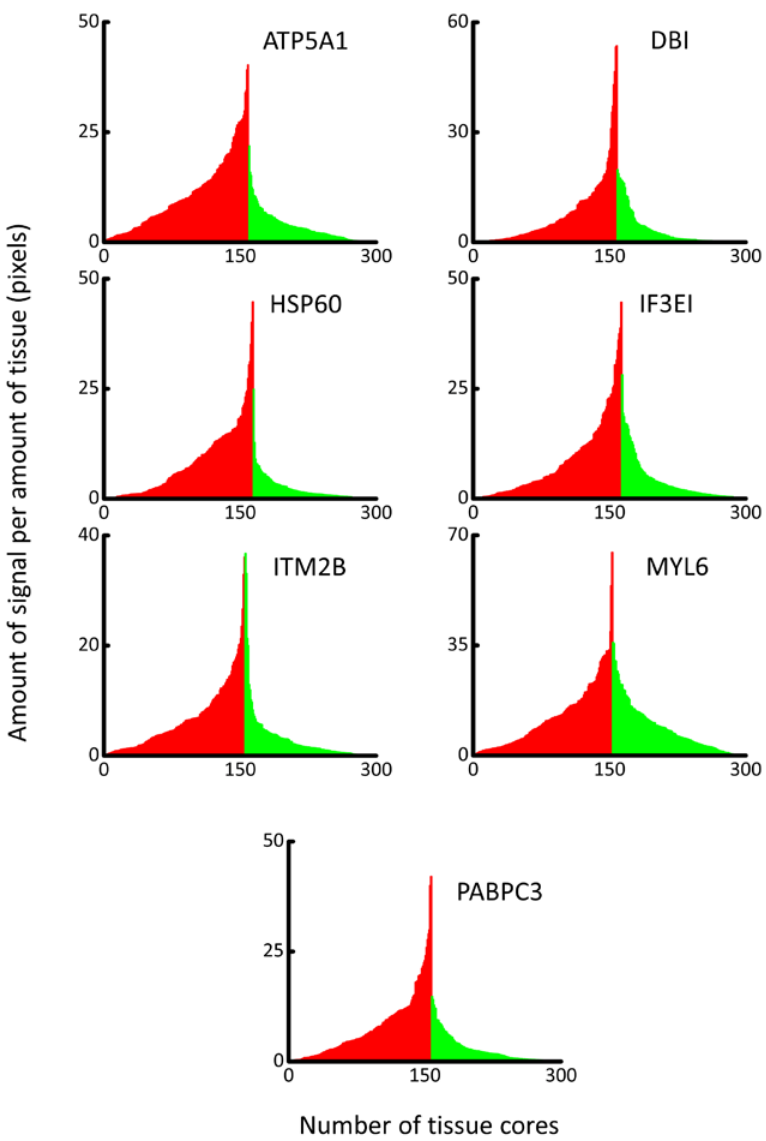
Figure 2. Mountain Plots . The total area of DAB stain and the total quantity of tissue present in each tissue core (pixels) was measured using a high throughput, semi-automated protocol using ImageJ software. Mountain plots illustrating the amount of DAB signal per amount of tissue in each tissue core. Red bars represent HR cores arranged in ascending order and green bars are LR tissue cores arranged in descending order. Plots were constructed in Origin (OriginLab, Northampton, MA, USA) software. Significant differences between protein expression in HR and LR tissue cores were observed in all proteins tested: ATP5A1 ( p < 0.001), DBI ( p < 0.001), HSP60 ( p < 0.001), IF3EI ( p < 0.001), ITM2B ( p < 0.001), MYL6 ( p = 0.0012), and PABPC3 ( p < 0.001).